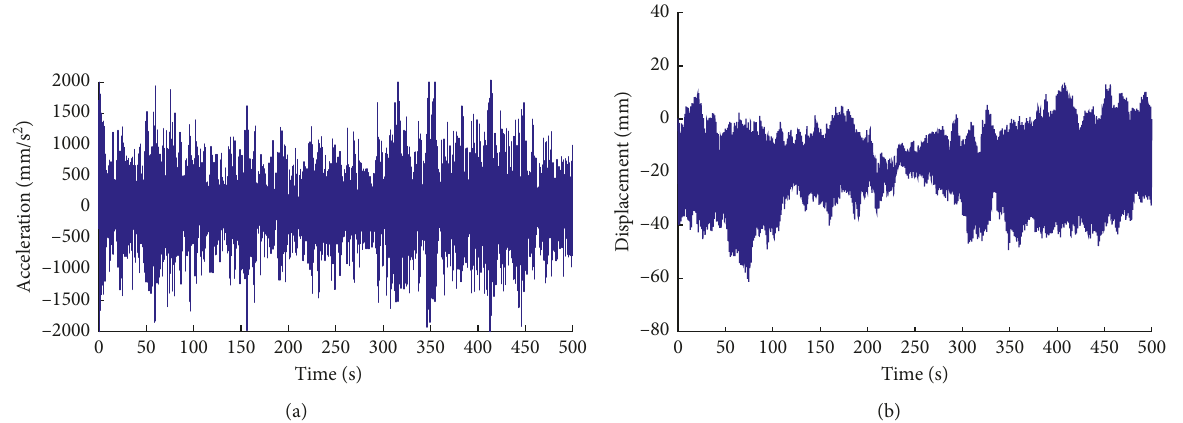
Figure 3: Time-history curves of acceleration and displacement at 50m: (a) acceleration at 50m; (b) displacement at 50 m.